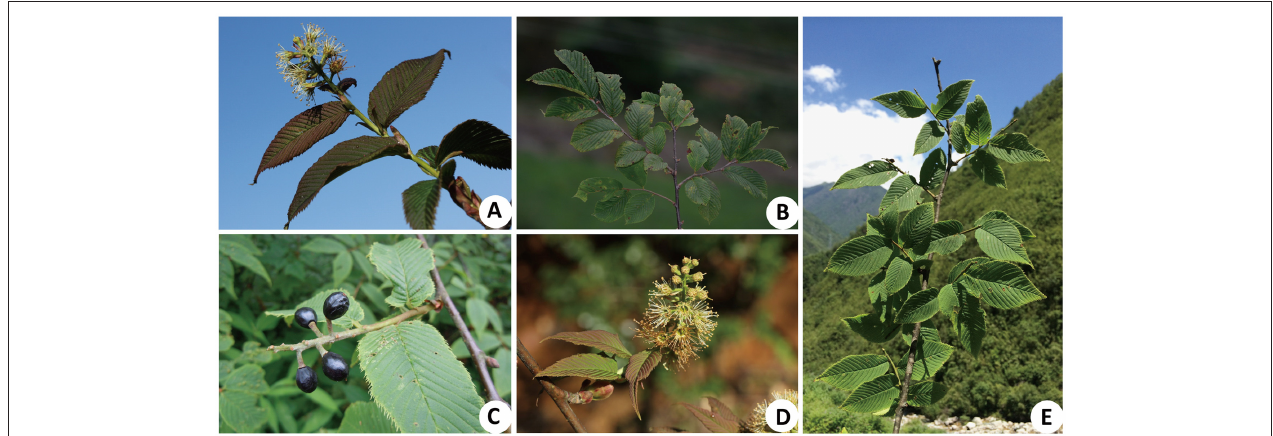
FIGURE 1 | Morphological characteristics of Maddenia species. (A) Prunus incisoserrata ; (B,C) P. wilsonii ; (B) simple leaf and serrated leaf margin; (C) drupe; (D,E) P . hypoxantha ; (D) racemose inflorescence; (E) simple leaf and serrated leaf margin.